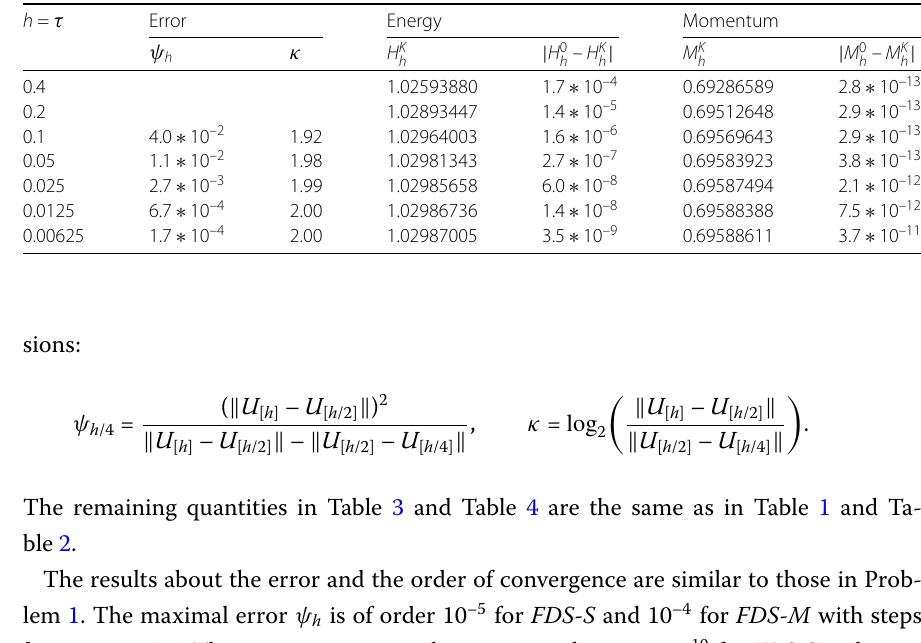
Table 4 Error, energy and momentum for Problem 2 using FDS-M h = τ Error Energy